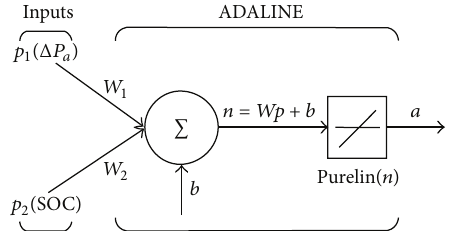
Figure 9: Model of a simple ADALINE neural network.